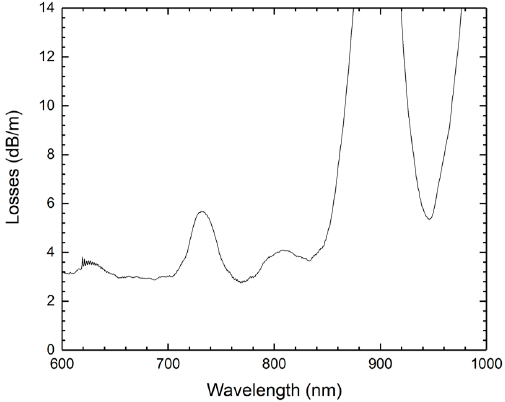
Figure 2. The loss spectrum of the microstructured polymer optical fiber.